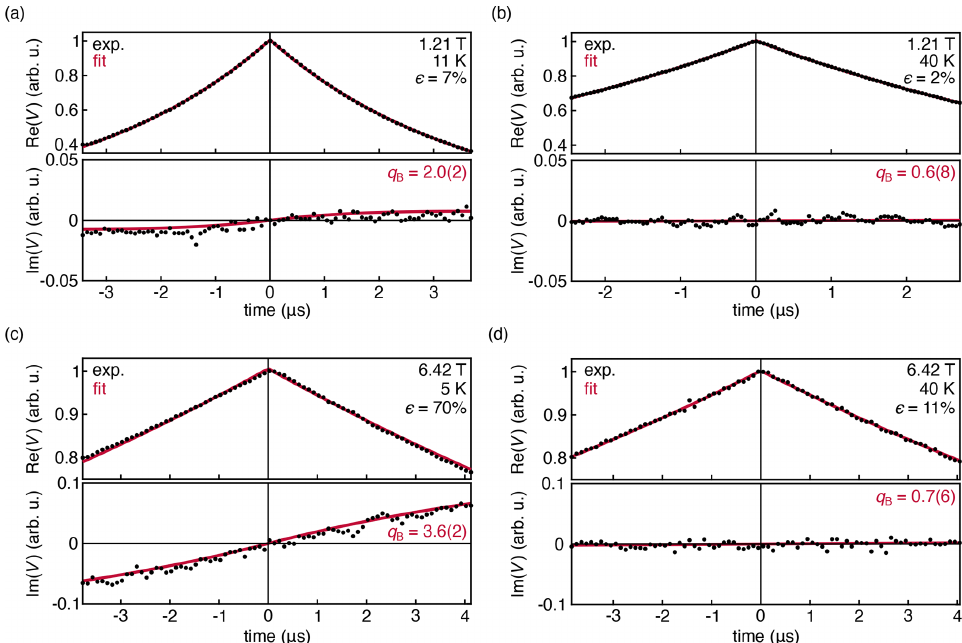
Figure 4. Experimental DEER traces for a 1.0mM solution of TEMPO in 50 : 50 D 2 O : d 8 -glycerol, measured at 33.9GHz at 11K (a) and 40K (b) . Experimental DEER traces for a 1.0mM solution of TEMPOL in 45 : 55 D 2 O : d 8 -glycerol, measured at 180GHz and 6.42T at 5K (c) and 40K (d) . The data were fit with Eq. (14) and are shown with their 95% confidence interval in parentheses. All fit parameters are shown in Table S1 in the